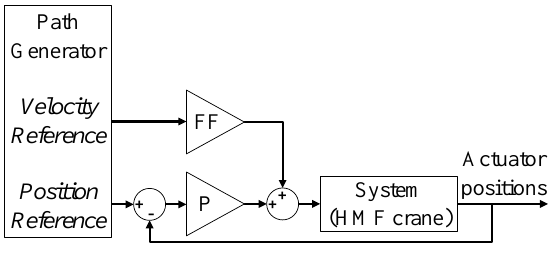
Figure 11. Control system block